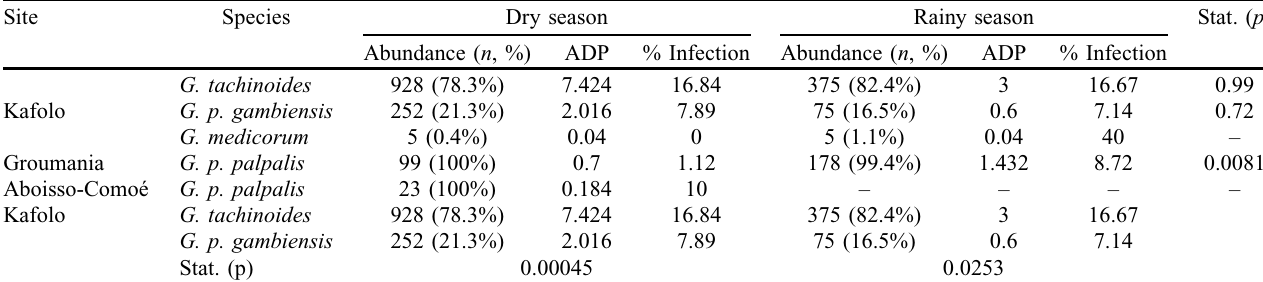
Table 1. Apparent Density per Trap (ADP) and tsetse infection rate depending on the species, areas and seasons.